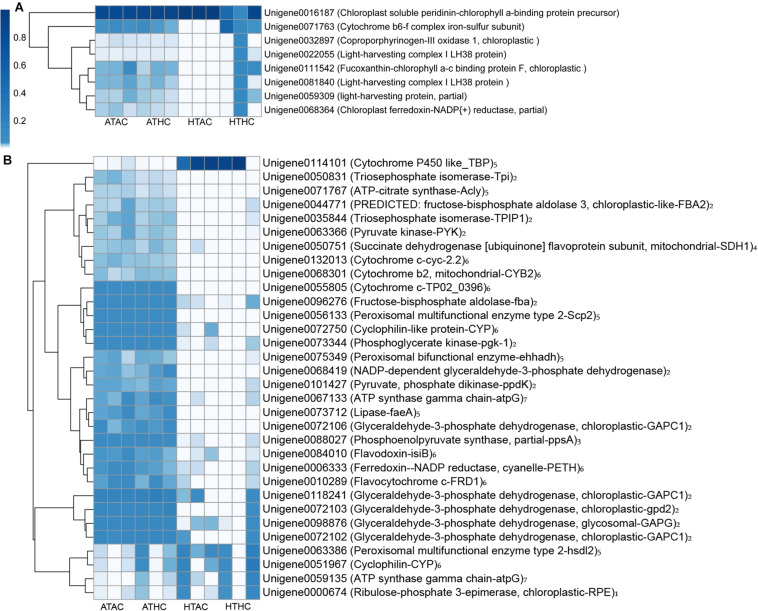
Heatmap of annotated unigenes related to photosynthesis (A) and metabolic processes (B) in the symbionts under the ATAC (28°C and pCO2 ∼600 μatm), ATHC (28°C and pCO2 ∼1,200 μatm), HTAC (30.5°C and pCO2 ∼600 μatm), and HTHC (30.5°C and pCO2 ∼1,200 μatm) treatments. Number 1–7 represents Calvin cycle, glycolysis, gluconeogenesis, TCA cycle, lipid or fatty acid metabolism, respiration chain and ATP synthesis category, respectively. The heatmap was drawn based on the log-transformed RPKM value of unigenes. The color bar in the heatmap represents the variation of the value of RPKM (from white to blue means the expression value of unigene from 0 to 1). High expression (blue color) represents the high value of RPKM, which means that the expression level of unigene among different groups or different unigenes is high. Unigenes were functionally categorized based on database searches and literature.